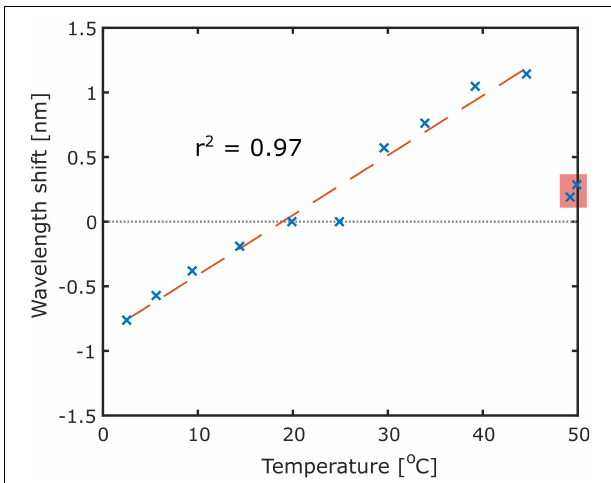
FIGURE 3 | Thermal stability of the spectrometer displayed as wavelength change of the 313.155 nm mercury emission line with temperature. Shifts are shown relative to the peak location at 25 ◦ C. A linear regression model indicates a wavelength shift dependence of 0.046 nm/ ◦ C, with a good model fit of r 2 = 0.97. The two high-temperature points, boxed in red, do not follow the linear trend, and may be caused by a larger scale shift in one of the optical components in the PiSpec. These data are not included in the regression analysis, since they are clearly associated with a different mechanism. Nevertheless, they should not be ignored, and suggest that at high temperatures > 45 ◦ C the PiSpec may begin to become unstable. In general, such high temperatures should be easily avoidable by keeping the instrument out of direct sunlight.